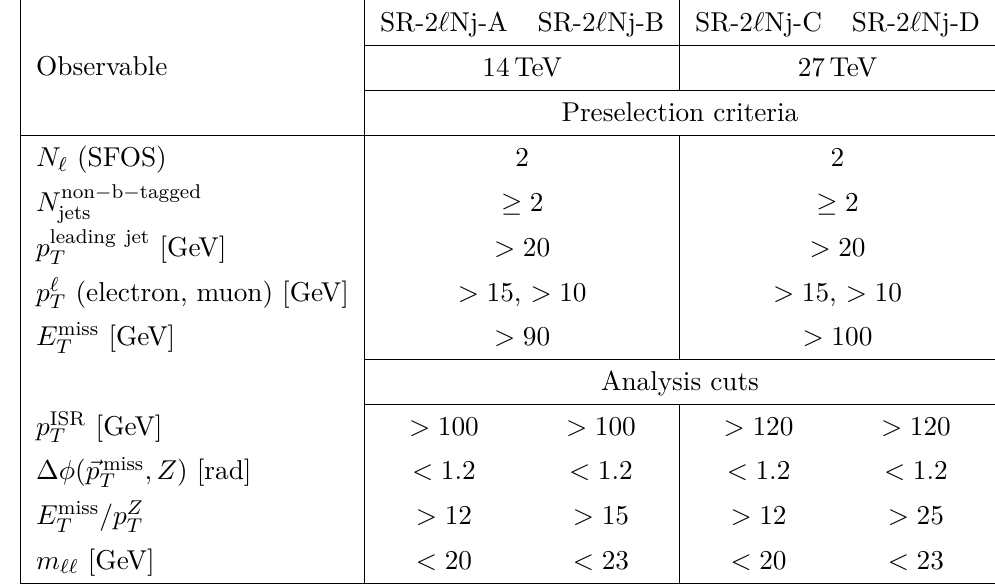
Table 9 . Preselection and analysis cuts (at 14 TeV and 27 TeV) applied to the signal and SM backgrounds for two signal regions targeting low and high electroweakino mass